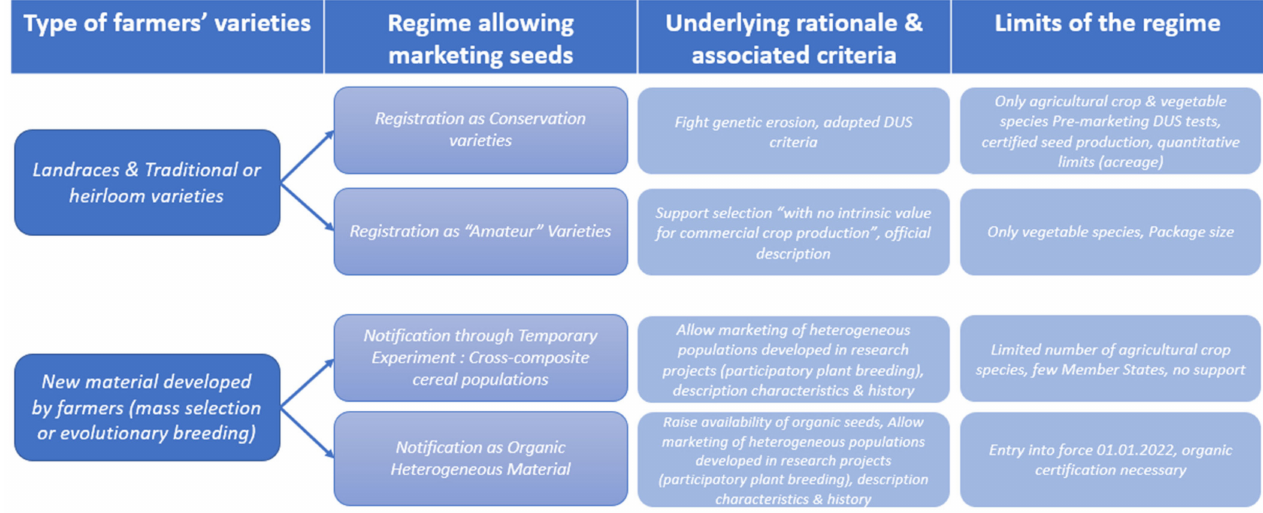
Figure 1. Different pathways for the registration of farmers’ varieties in the